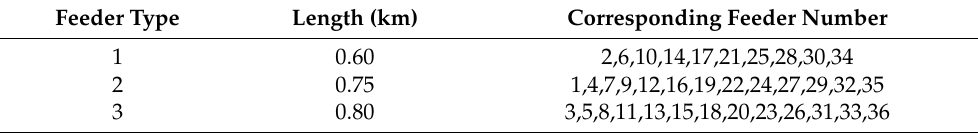
Table A2. Feeder type and length for RBTS-BUS2.